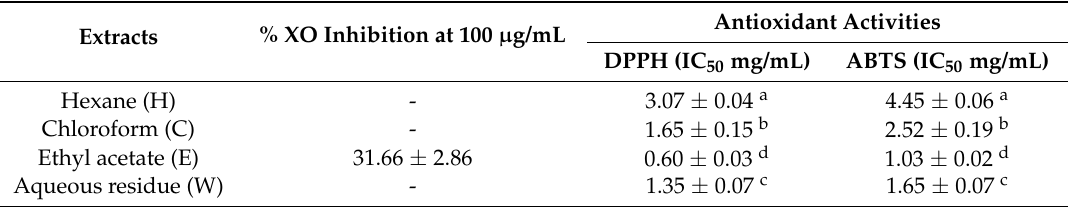
Table 1. Xanthine oxidase inhibitory and antioxidant activities of C. militaris .